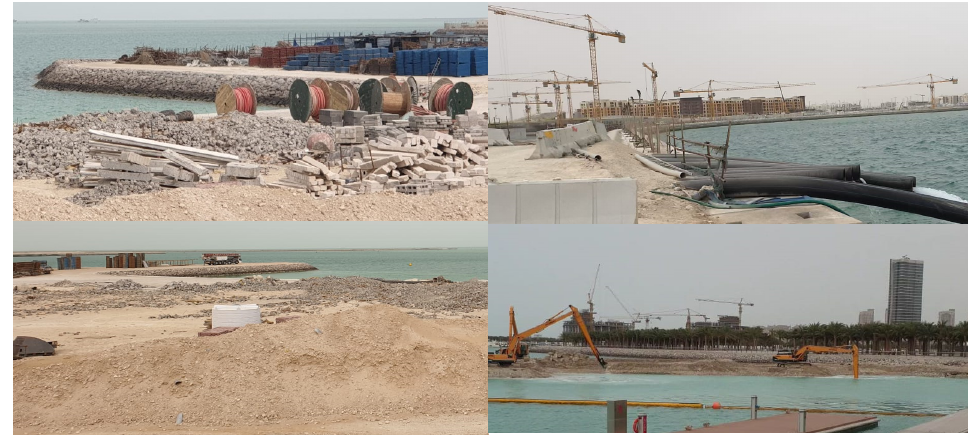
Figure 10. Ongoing coastal construction in Lusail City.